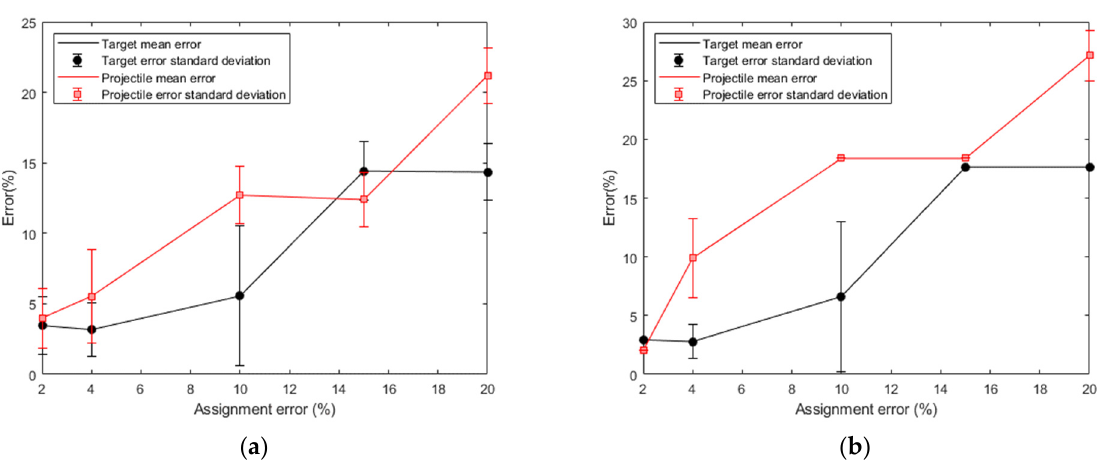
Figure 12. ( a ) Mean and standard deviation errors for number of fragments greater than 10 cm, both for target and projectile. ( b ) Mean and standard deviation errors for estimated fragmented mass, both for target and projectile.